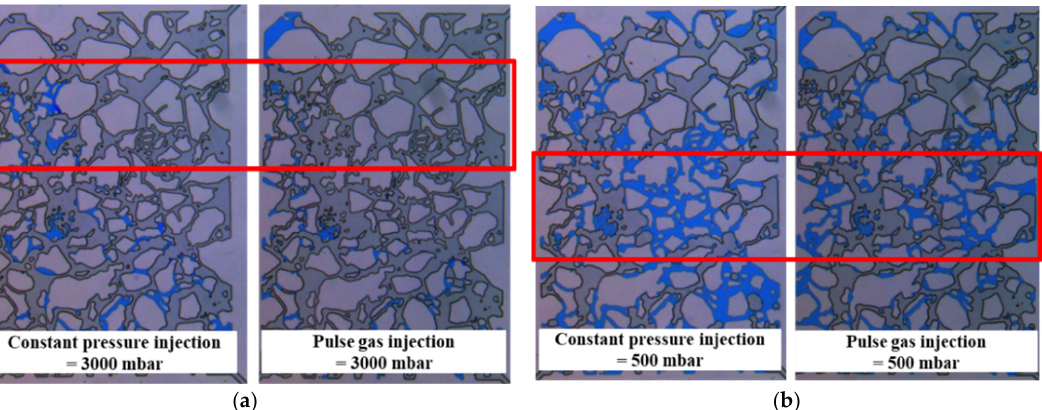
Figure 12. Liquid phase retention comparation under different gas injection methods, 200 μ m model. ( a ) 3000 mbar high pressure; ( b ) 500 mbar low pressure.